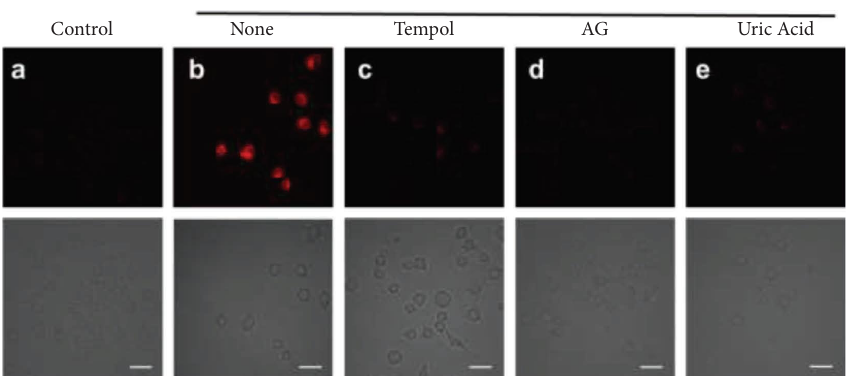
Figure 5: Imaging of endogenous ONOO − in RAW 264.7 cells. (a) Cells were preincubated with HND-ONOO. Te cells were stimulated with LPS/INF- c and then incubated with HND-ONOO. Te cells were stimulated with LPS/INF- c and treated with (c) Tempol, (d) AG, and (e) uric acid and then stained by HND-ONOO. Te scale bar is 20 μ